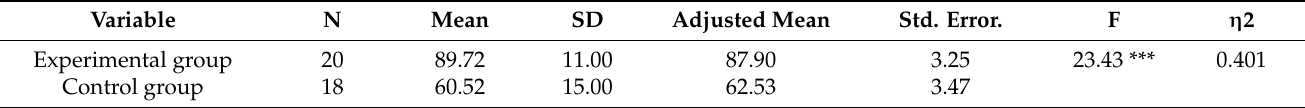
Table 2. ANCOVA study results for the experimental group and the control group.